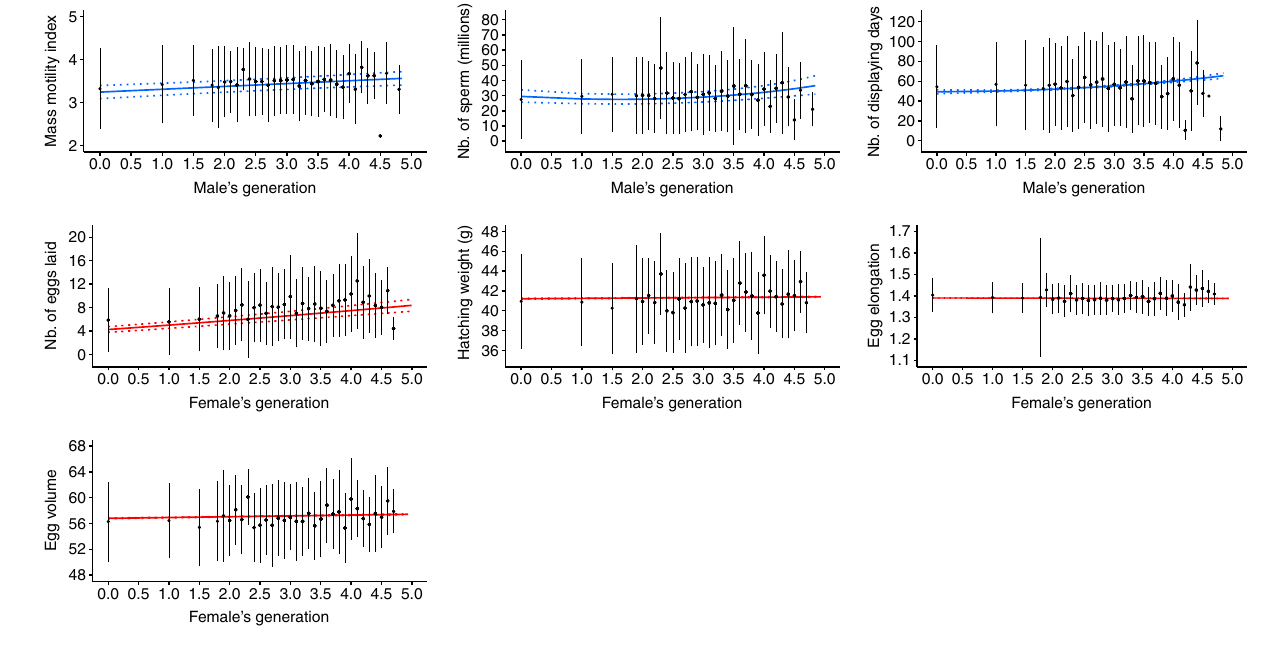
Figure 3. Predicted values of reproductive parameters according to number of generations in captivity. Solid blue lines represent male reproductive parameters while solid red lines represent female reproductive parameters. Dotted lines represent the 95% confidence intervals. Black filled points represent average phenotypic values computed on raw data and the vertical lines represent the associated standard deviations.